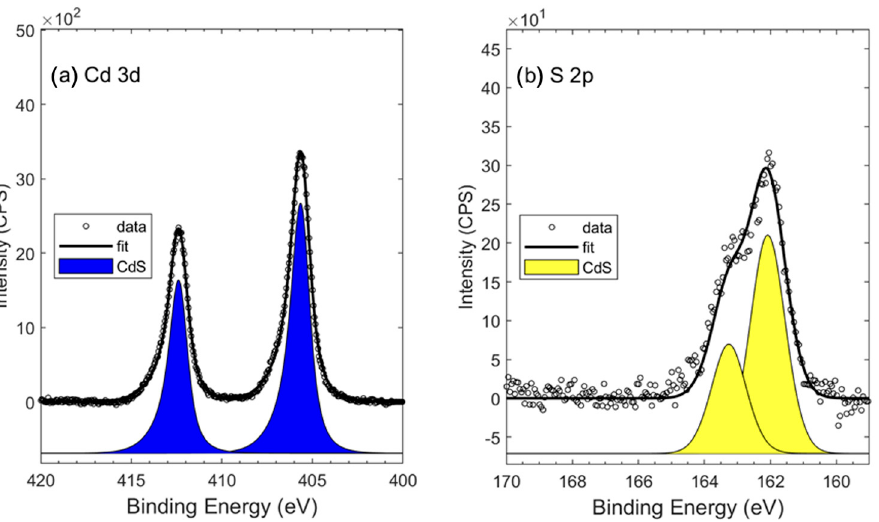
Figure 5. High-resolution XPS spectra of Cd 3d and S 2p of CdS-HTa400, fitted with doublets with fixed spin-orbit energy separation of 6.74 eV and 1.18 eV, respectively.